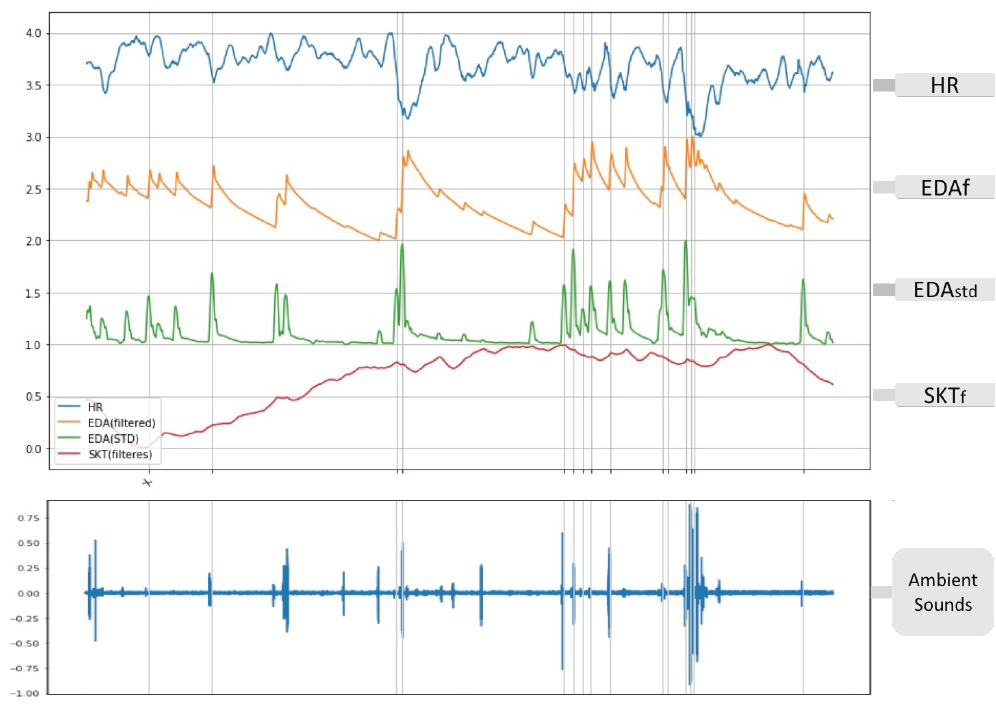
Figure 5. Physiological responses for continuous emotion